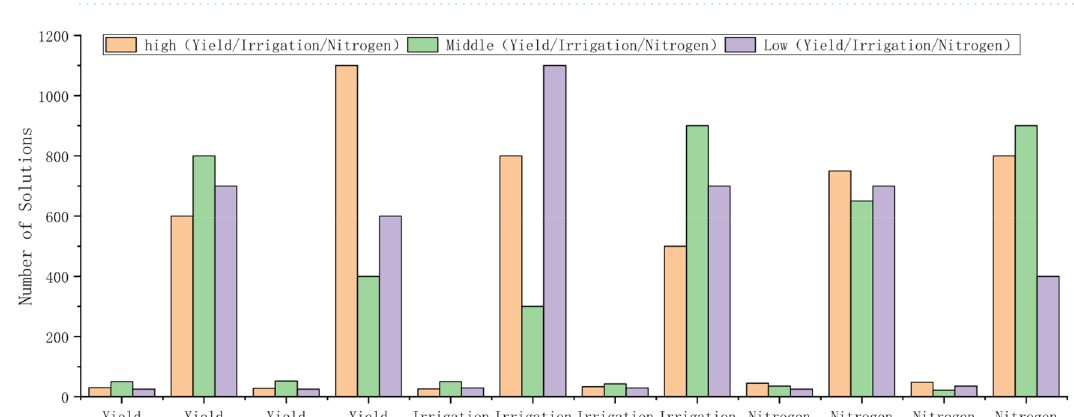
Figure 10. Boxplot of total irrigation( b ) and total yield( a ) for the six strategies.